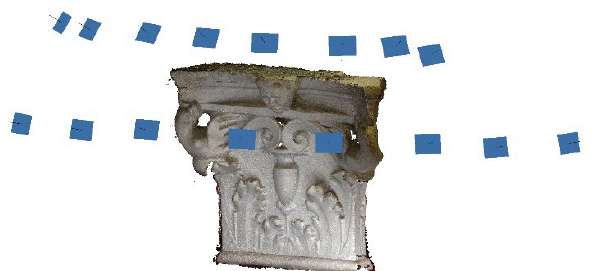
Figure 5. Polygonal model of a capital of the Tribuna, generated with SfM photogrammetric